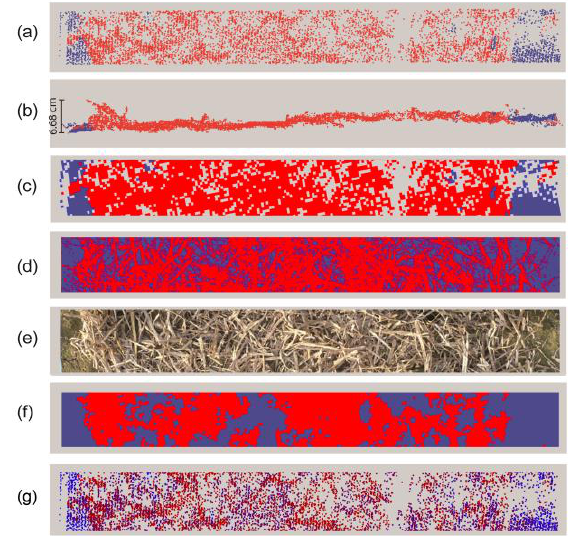
Figure 6: 1-m transect through classified point cloud: a) top view of classified points, b) point cloud profile, c) rasterized binary map, d) corresponding image reference classification, e) RGB image of maximum residues cover, f) nDSM layer residues cover and g) coloured point cloud based on single corrected amplitude values only. Red: harvest residues, blue: bare soil.